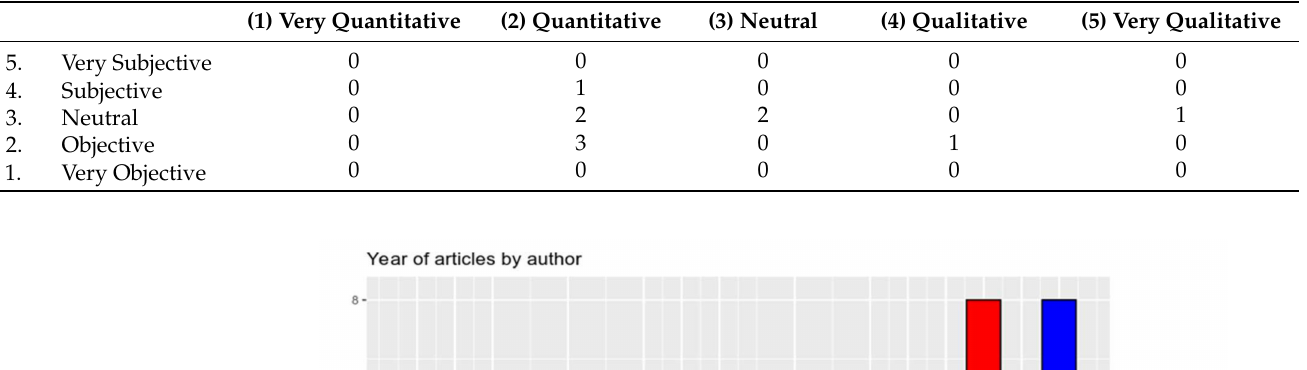
Table 5. Author 3 sources (10 sources).